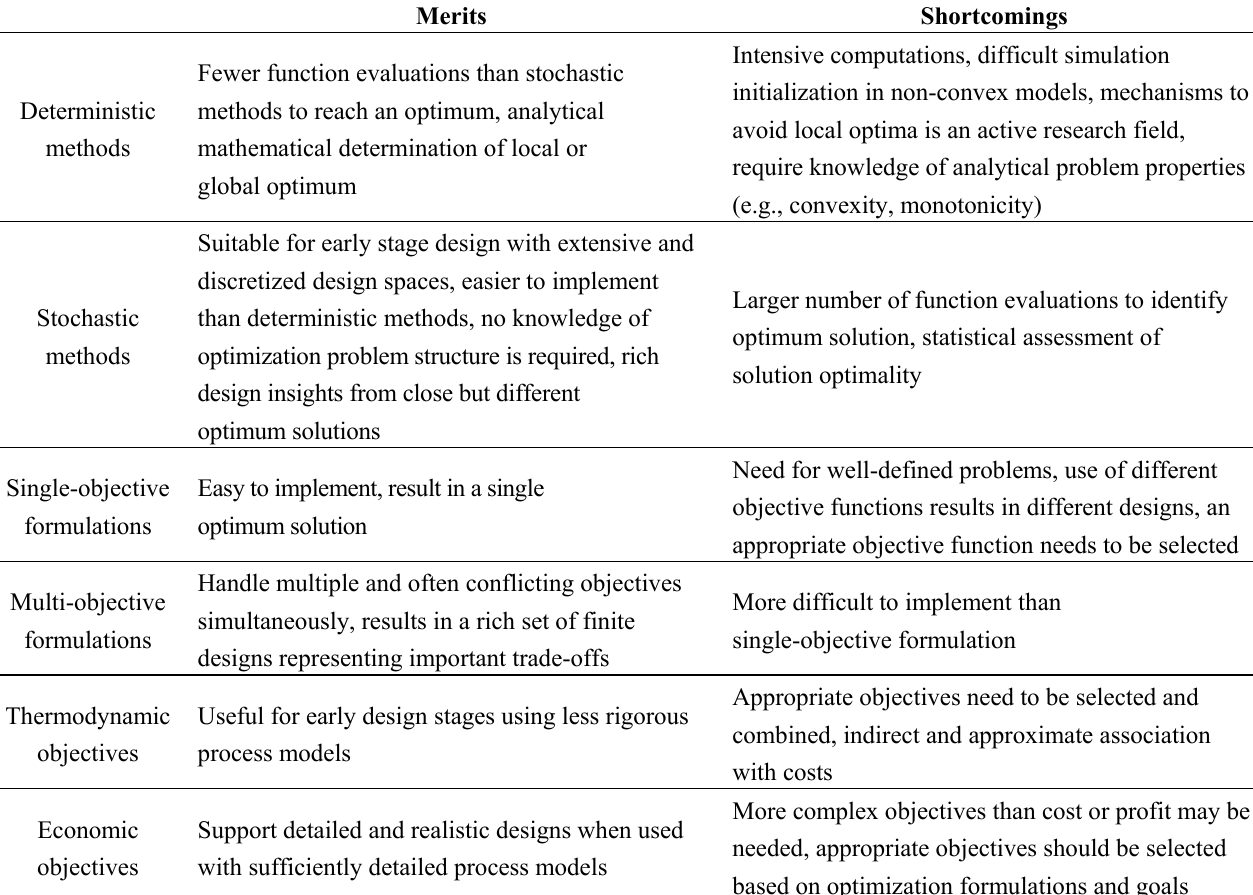
Table 7. Merits and shortcomings of considered methods and objective functions in process